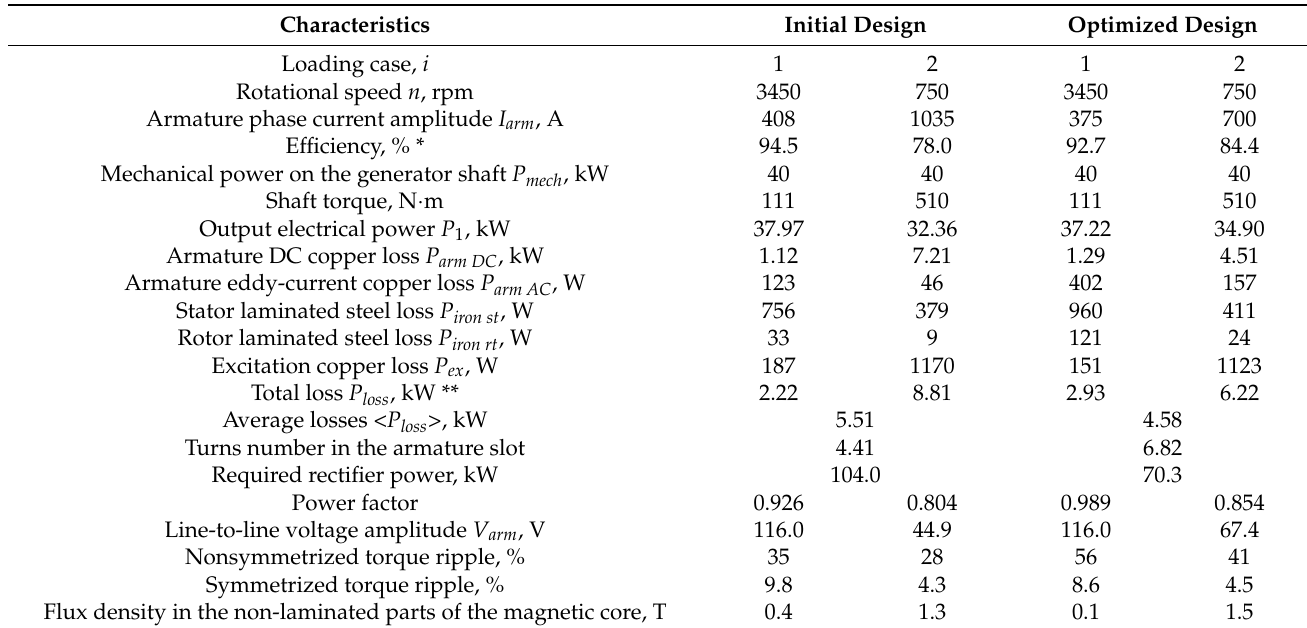
Table 3. Generator characteristics before and after optimization.